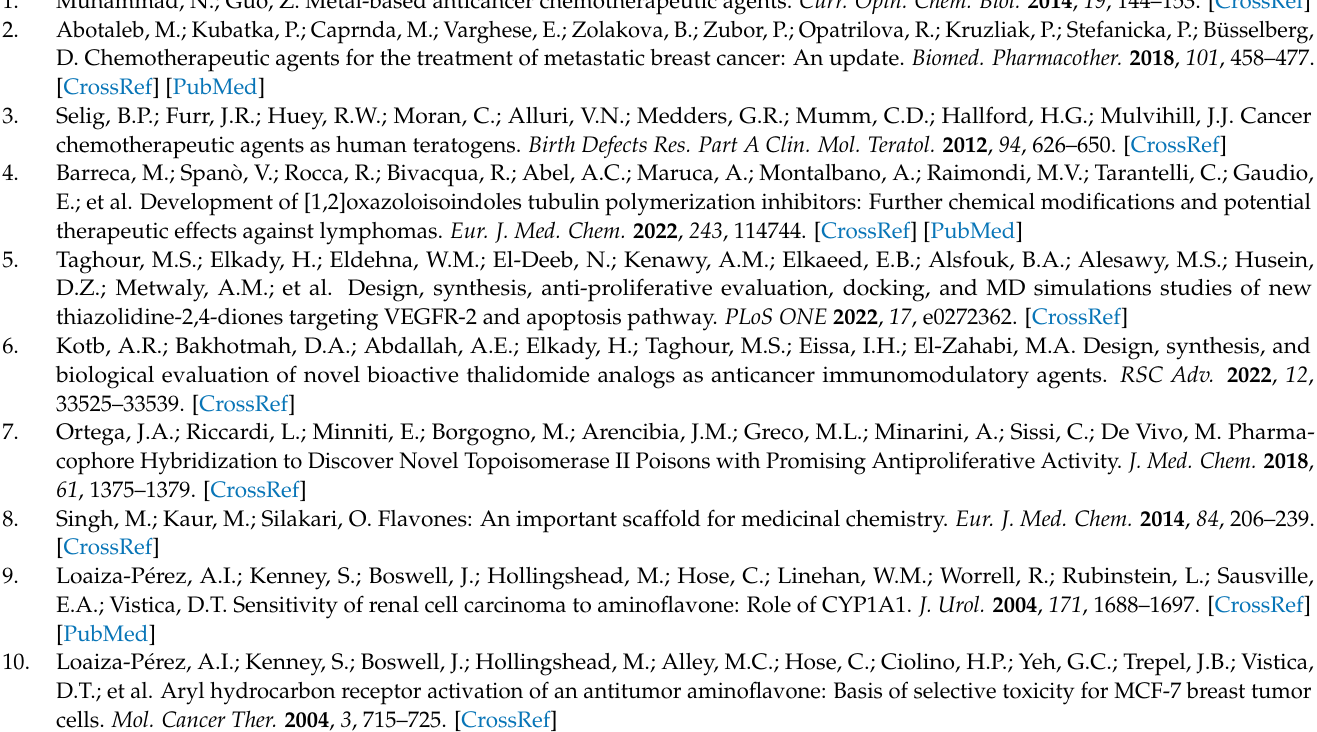
analysis; Figure S2: IC50 curves; Figure S3: Copies of 1 H NMR and 13 C NMR Spectra; Figure S4: Copies of HRMS